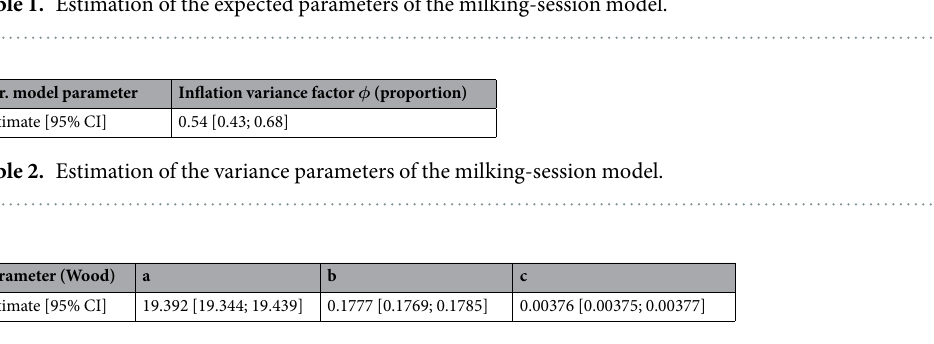
Table 1. Estimation of the expected parameters of the milking-session model.